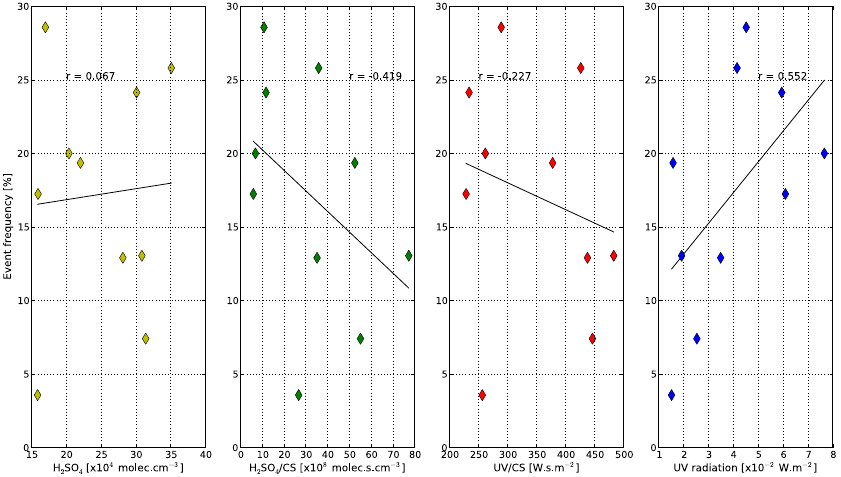
Fig. 5. Relation between events frequency and atmospheric